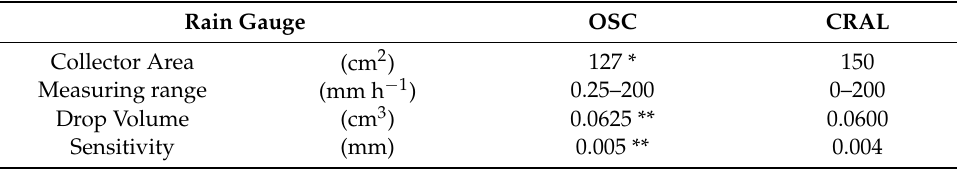
Table 1. Main characteristics of the two DC rain